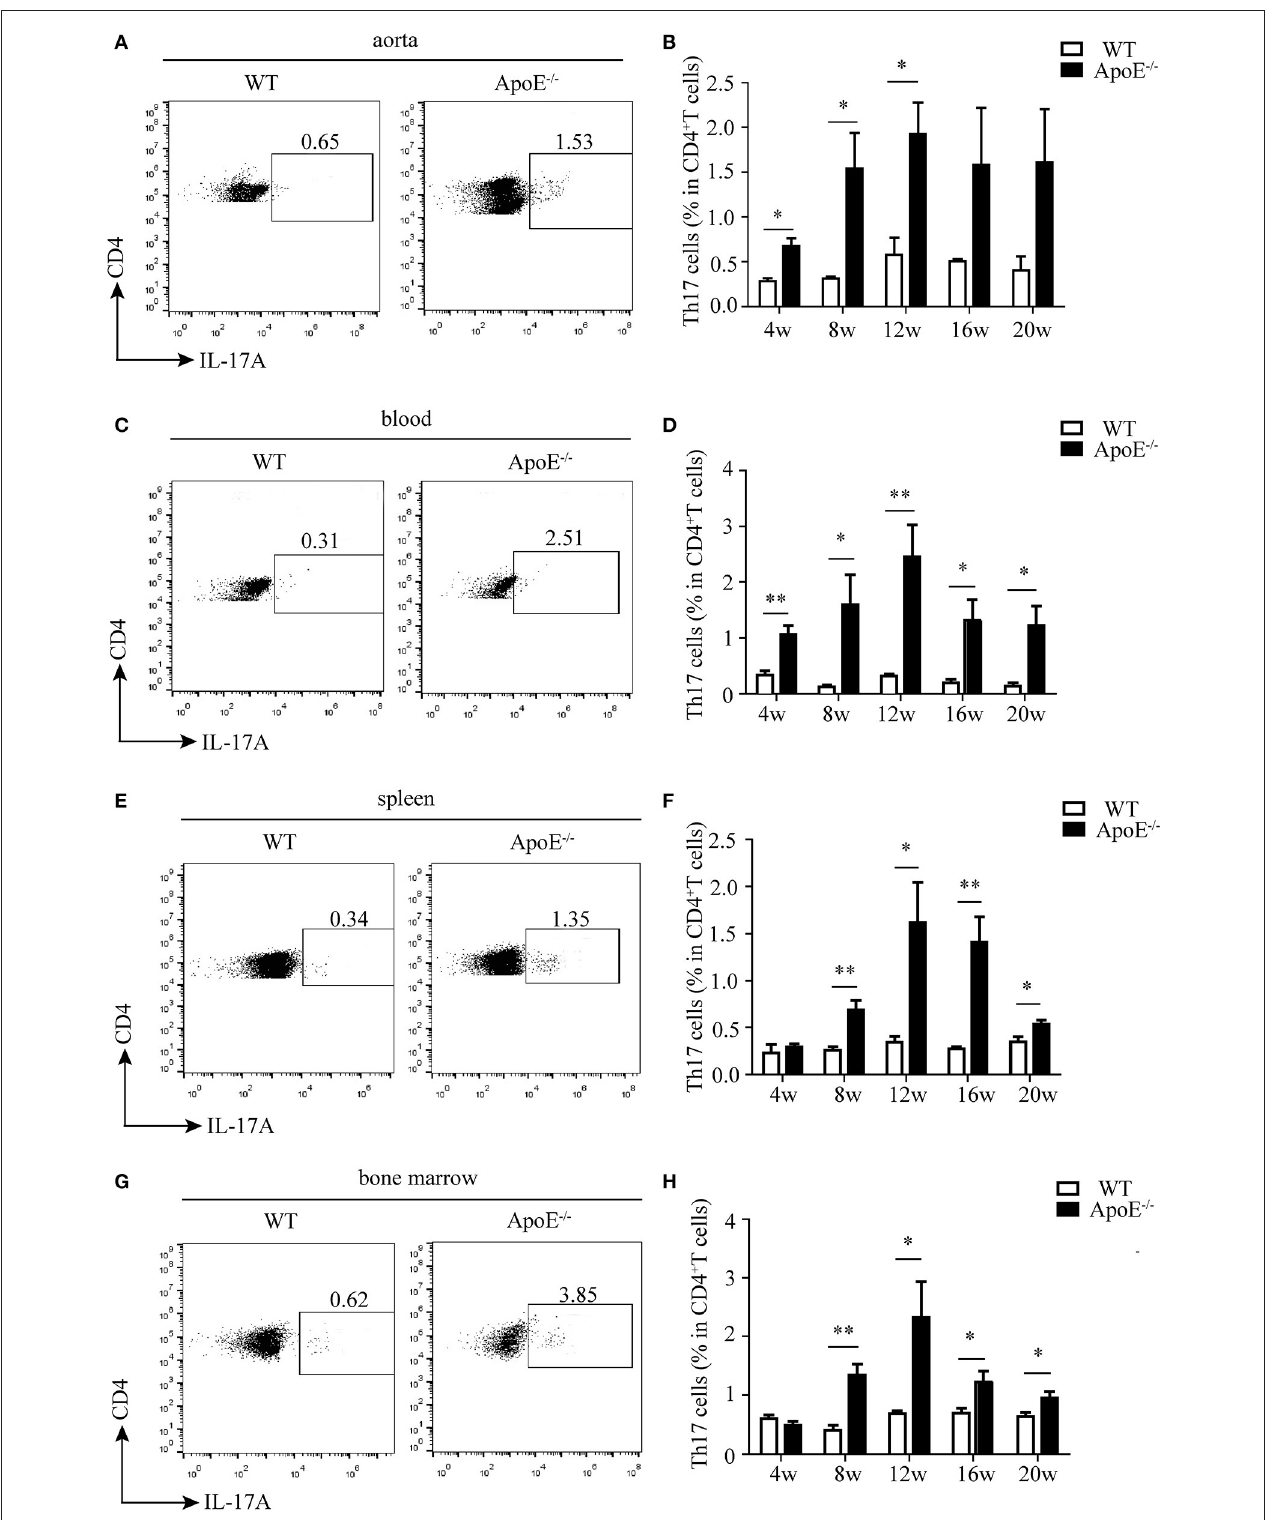
FIGURE 2 | Ratio of Th17 cells in CD3 + T cells in different tissues and organs. Representative dot plots of intracellular staining of IL-17 gating on CD4 + T cells in (A) aorta, (C) blood, (E) spleen, and (G) bone marrow of wild-type (WT) and ApoE − / − mice fed with high-fat diet (HFD) for 12 weeks. Th17 cell percentage in (B) aorta, (D) blood, (F) spleen, and (H) bone marrow of WT and ApoE − / − mice fed with HFD at different time points (4–20 weeks). Each group consisted of six mice. * p < 0.05, ** p < 0.01.